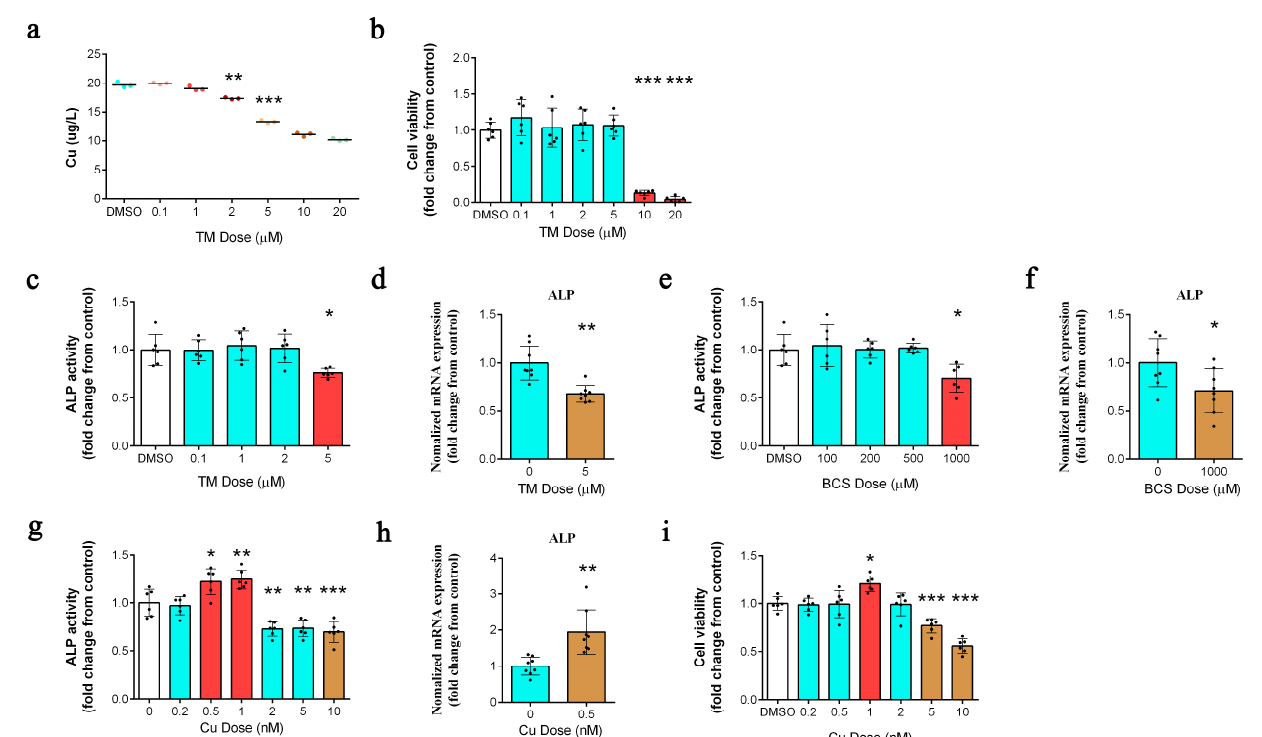
Figure 1. ( a ) Measurement of intracellular copper levels in dermal papilla cells (DPCs) after 72 h of treatment with different tetrathiomolybdate (TM) concentrations ( n = 3/group). ** p < 0.01, *** p < 0.001. ( b ) A cell counting kit-8 (CCK-8) assay was used to assess the effect of different TM